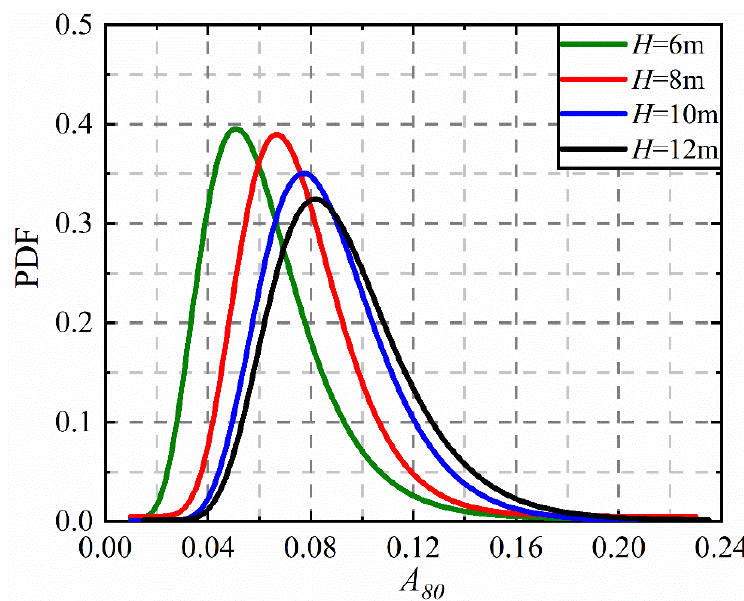
Figure 9. PDF of liquefaction range for different embedment depths.